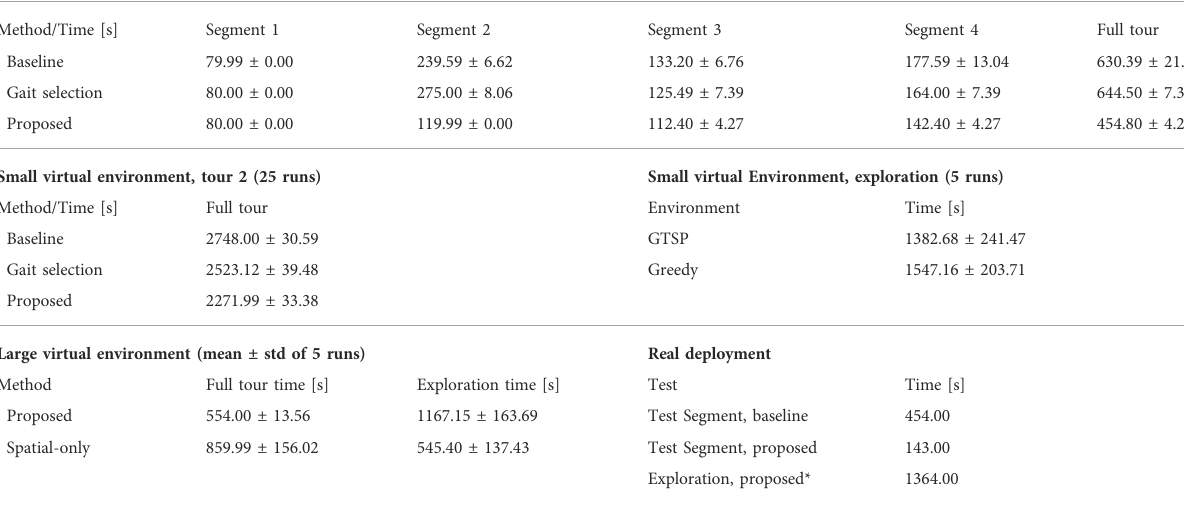
TABLE 5 Performance as the time (total cost) in seconds to